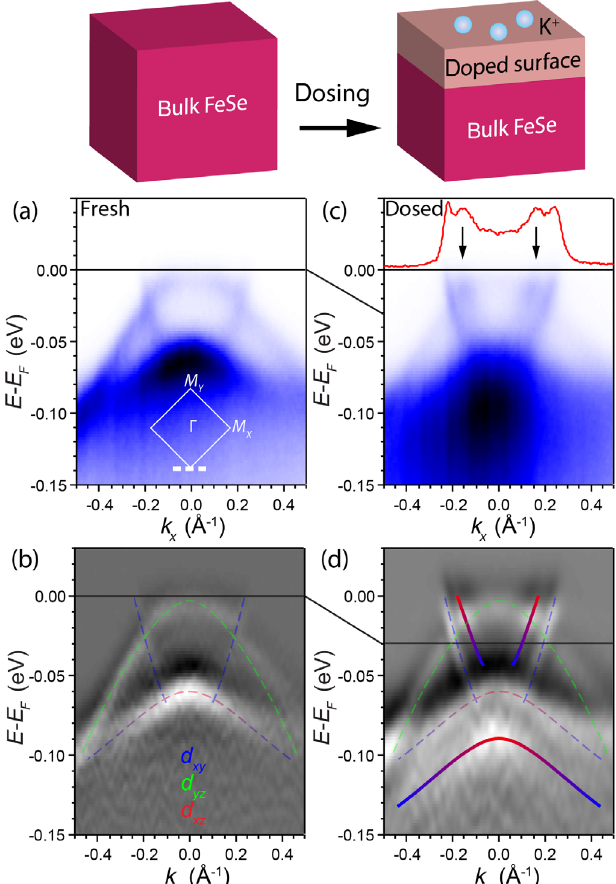
FIG. 6. Finding the missing second electron pocket by surface doping. (a) Raw spectra taken across M Y on a freshly cleaved detwinned FeSe, at 56 eV. (b) Second energy derivative of (a) with a schematic of band dispersions. (c) The same meas- urement as (a) but after doping the surface with potassium. The MDC at E F is plotted in red, with arrows indicating the new electron band induced by potassium doping. (d) Second energy derivative of (c), where the bands from the undoped bulk from (b) are reproduced as dotted lines and the new doped surface bands are marked by solid